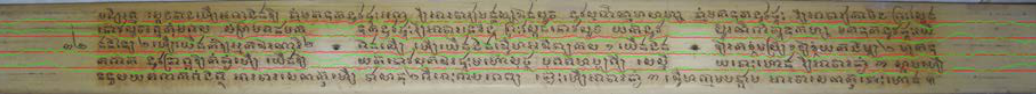
Figure 24. Text line segmentation of Khmer manuscript with the Seam Carving method (green) and Adaptive Path Finding (red).